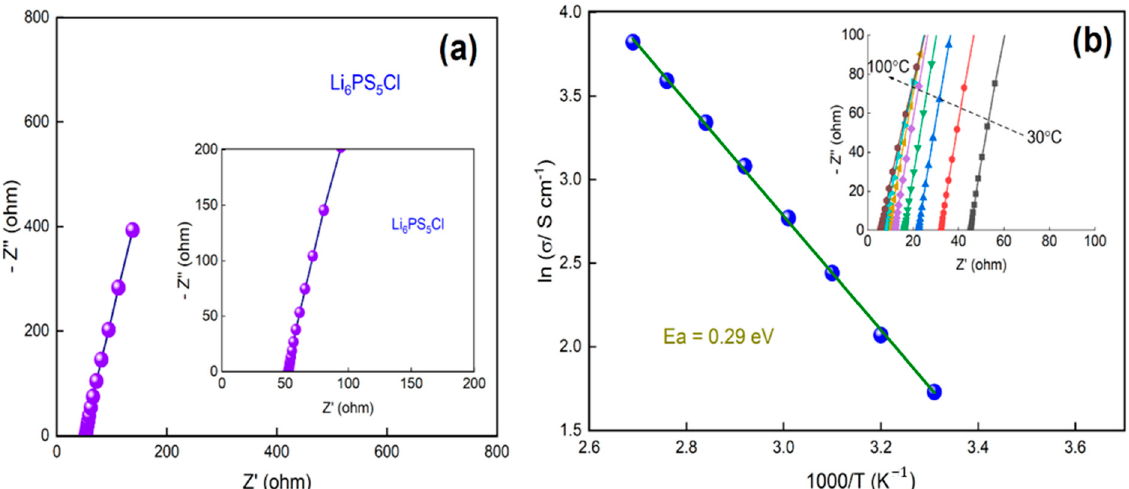
Figure 2. ( a ) Nyquist plot and ( b ) Impedance plots for conductivity data between 30 and 100 °C (insets) and the Arrhenius plot of the prepared Li 6 PS 5 Cl solid electrolyte. The initial charging and discharging analysis of the NCM622-Li 6 PS 5 Cl solid electrolyte system was conducted for the initial three cycles at a constant current density of 0.2 nA